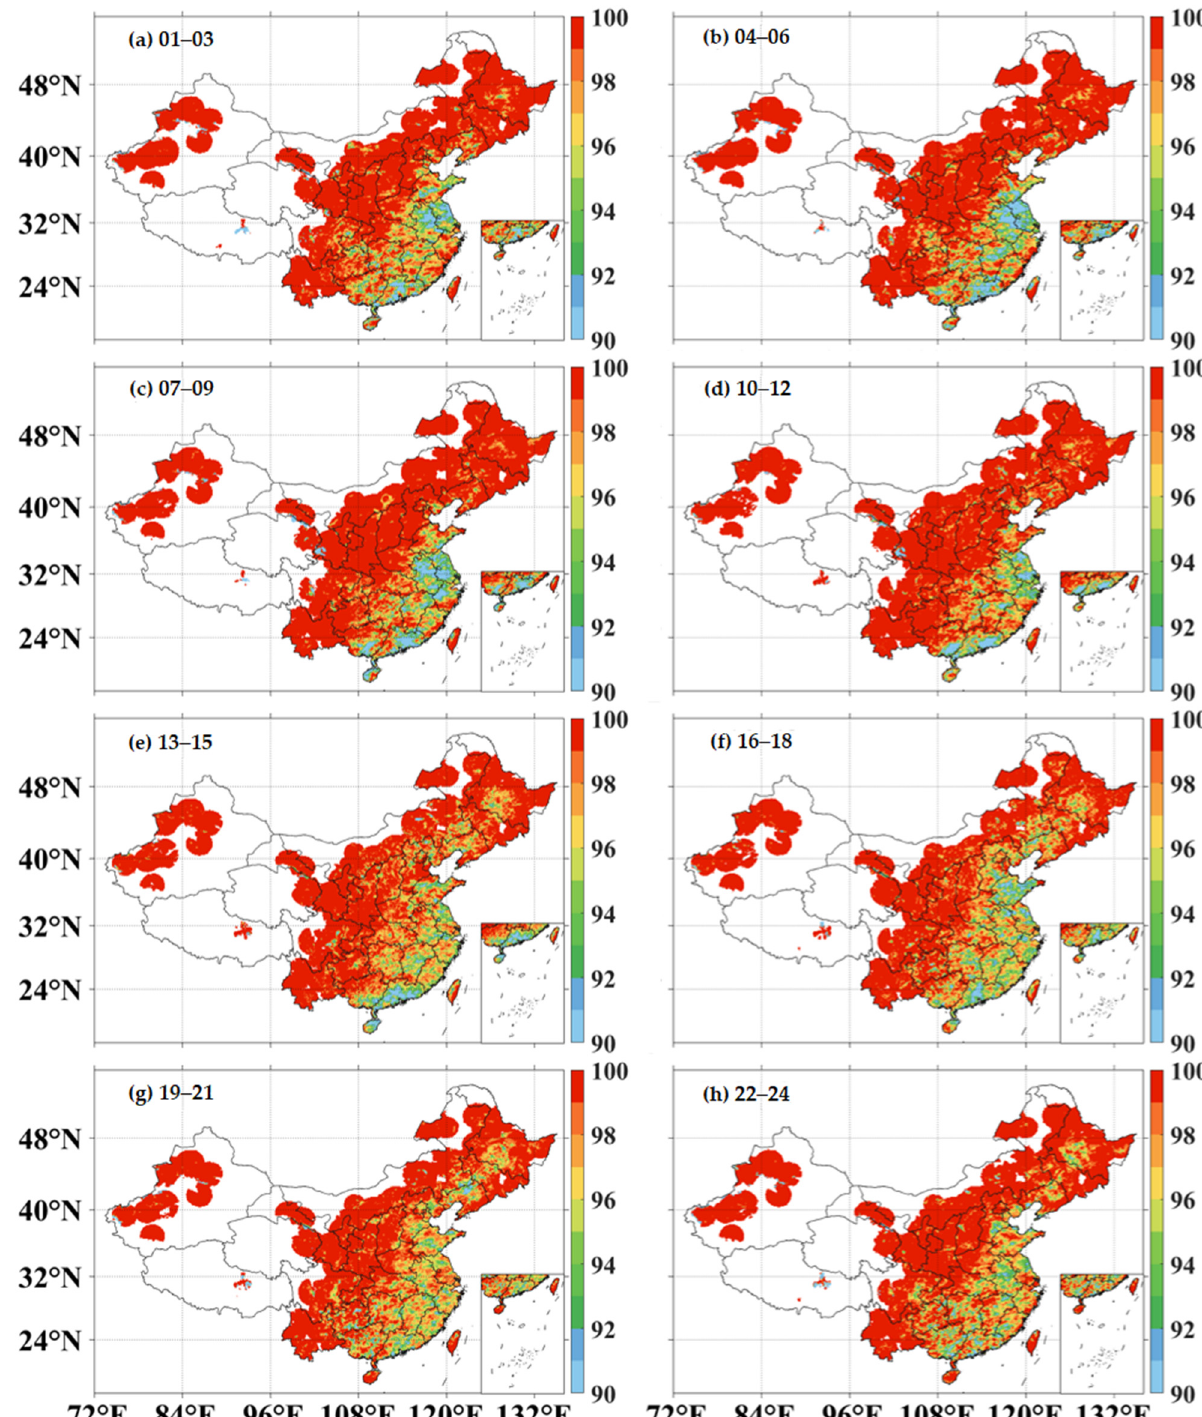
Figure 11. Diurnal variation of frequency (%) distribution of stratiform precipitation for period